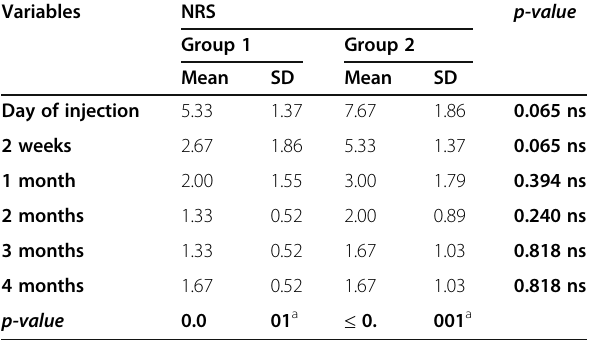
Table 1 The changes and differences in the pain scores according to the visual analogue scale throughout the study period ( SD standard deviation, ns non-significant) Variables NRS p-value Group 1 Group 2 Mean SD Mean SD Day of